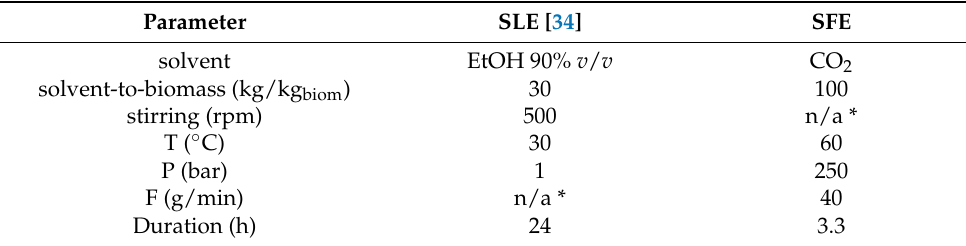
Table 4. Optimal conditions of SLE and SFE. Parameter SLE